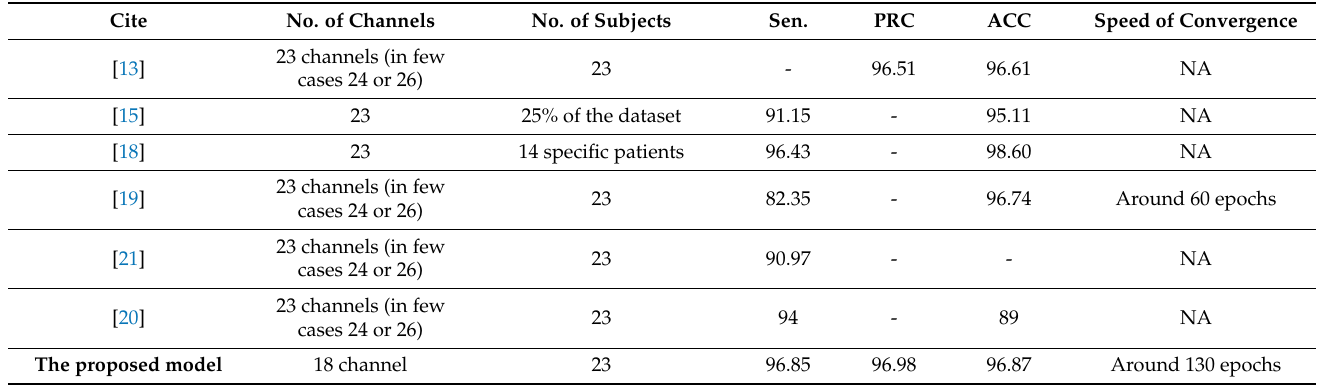
Table 6. Performance comparison of the proposed model with other systems on the CHB-MIT